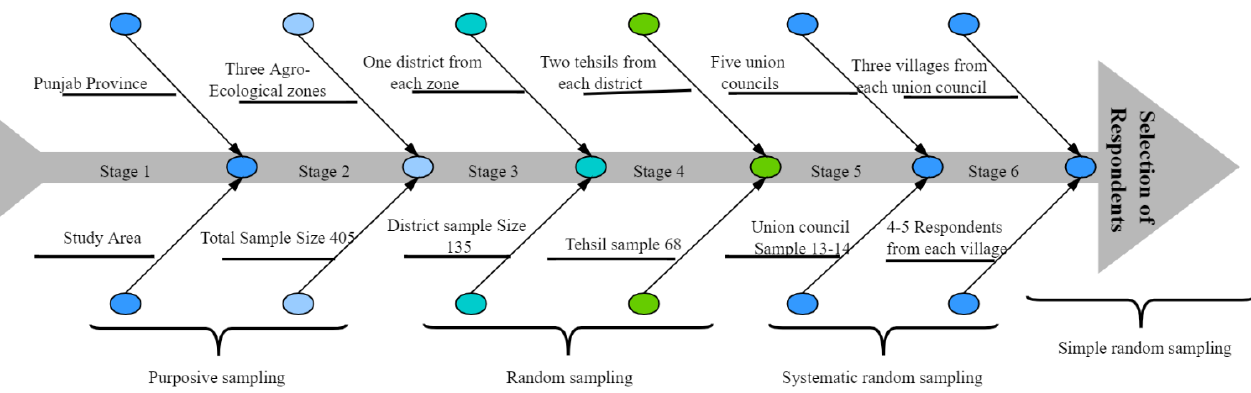
Figure 2. Sampling Figure 2. Sampling strategy.